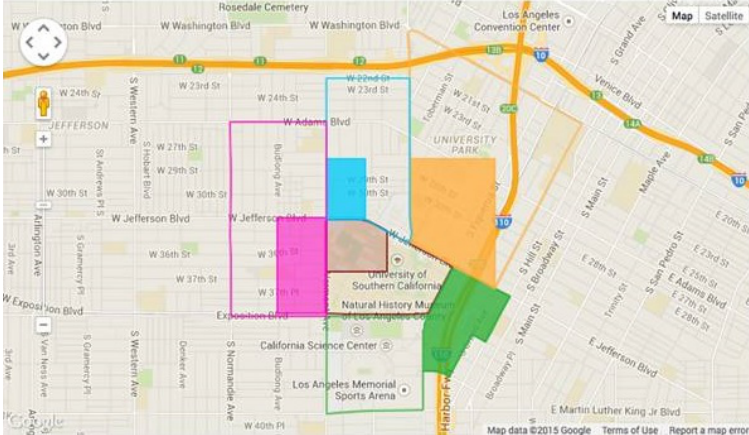
Figure 10. Sample patrol